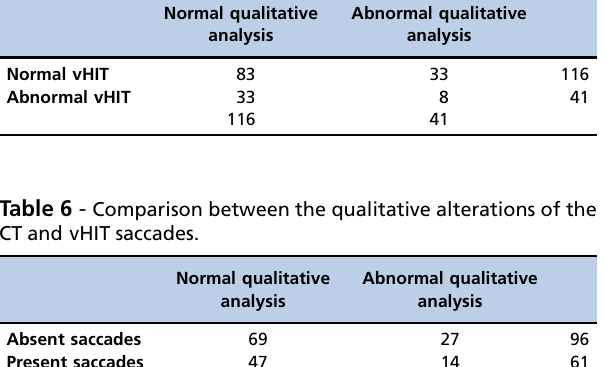
Table 5 - Comparison between the qualitative alterations of the CT and vHIT gain. Normal qualitative